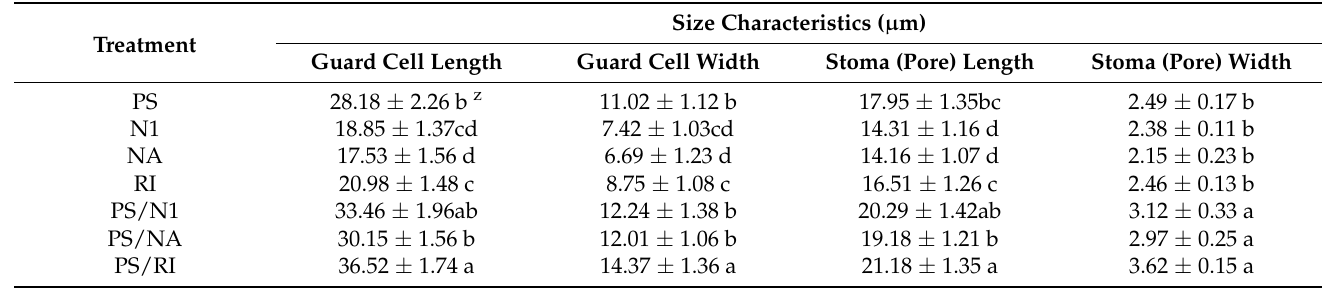
Table 2. The size of guard cells and stoma (pore) of scion, rootstocks, and grafted cut rose flowers grown in the greenhouse during the summer season.